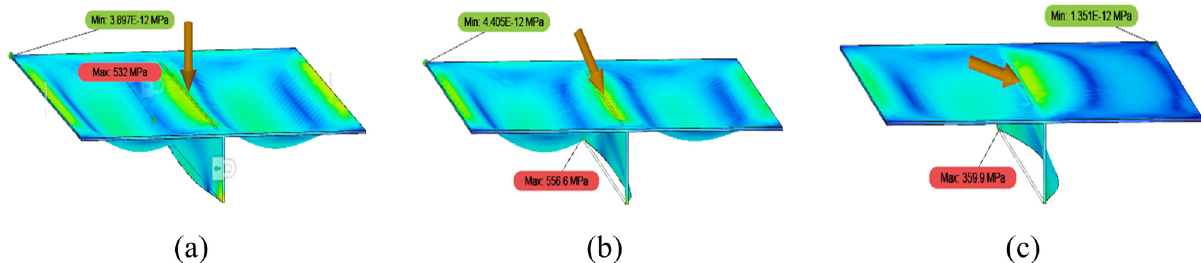
Figure 16: The contour of the von Mises stress of sti ff ened low - carbon steel material subjected to a linear global load ( Model 2 ) at the loading angles of ( a ) 0°, ( b ) 30°, and ( c ) 75°.